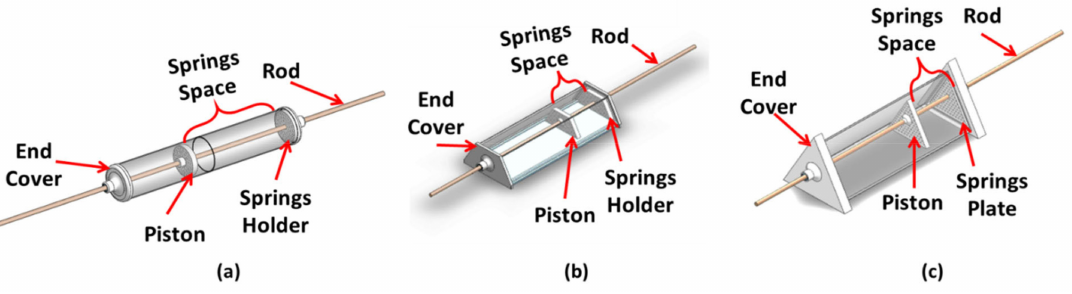
Figure 3. Overview of developed CAD models for ( a ) actuator A, ( b ) actuator B, and ( c ) actuator